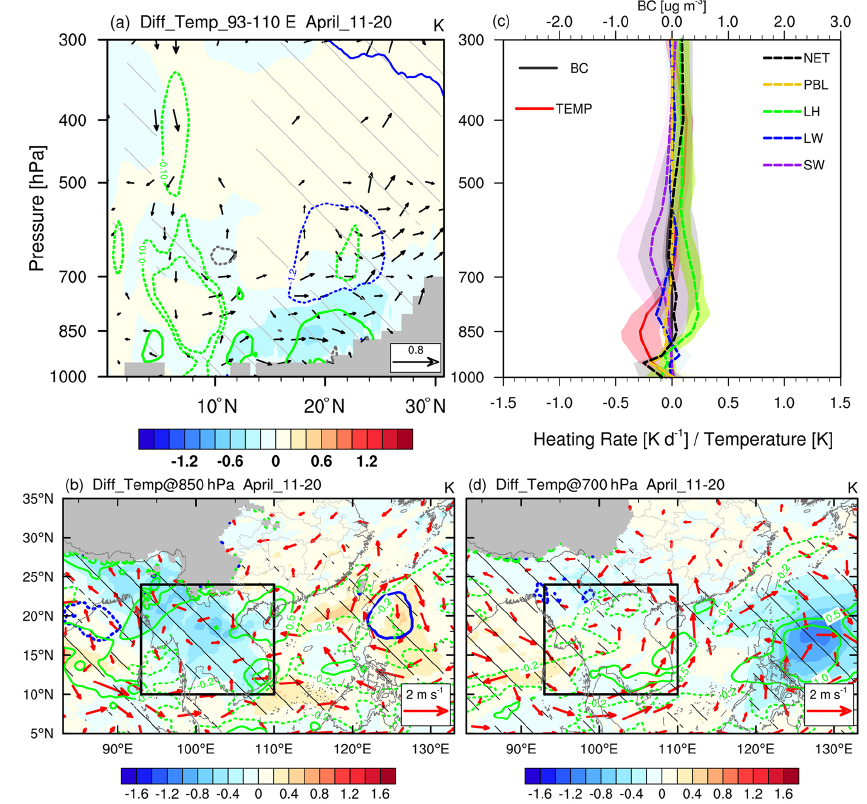
Figure 14. Same as Fig. 12, but the fields are averaged over 11–20 April 2010 (i.e., mid April).